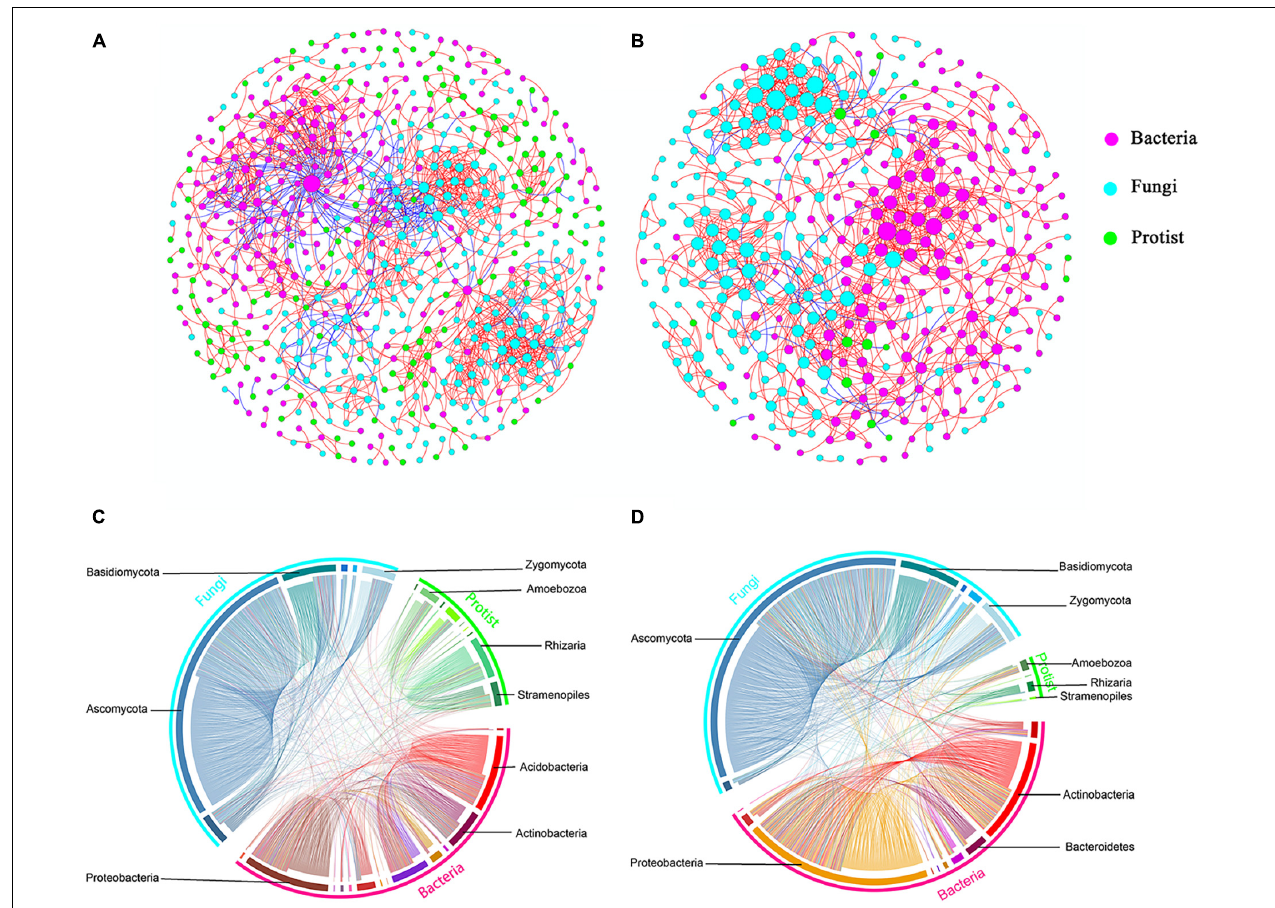
FIGURE 6 | Co-occurrence networks constructed from total microbial communities in bulk soil ( A , n = 18) and rhizosphere ( B , n = 18), respectively, and the distributions of bacteria, fungi and protist (C,D) . Each node represents an OTU, the size of each node is proportional to the degree (A,B) . Red and blue lines connecting nodes (edges) represent positive and negative relationships, respectively (A,B)